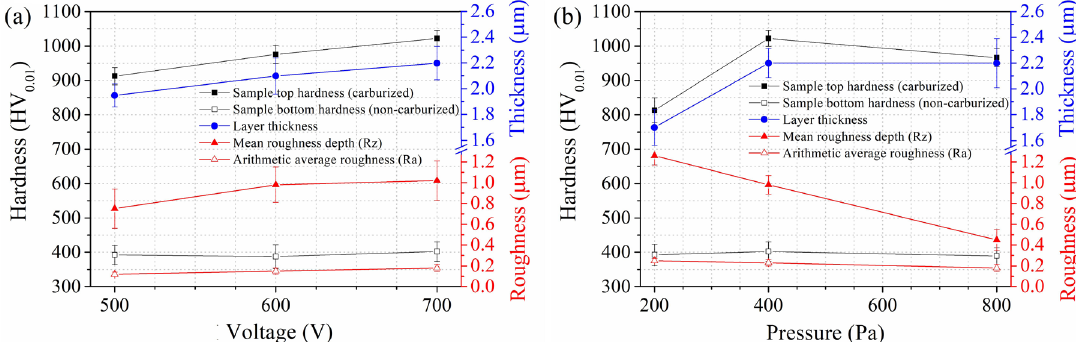
Figure 2. Vickers hardness measured on the carburized (top) and non-carburized (bottom) flat surfaces, layer thickness, and surface Ra and Rz roughness obtained for: a) applied pulse voltage; and b) pressure treatment series. Treatments carried out at 450 °C, for 8 h, using